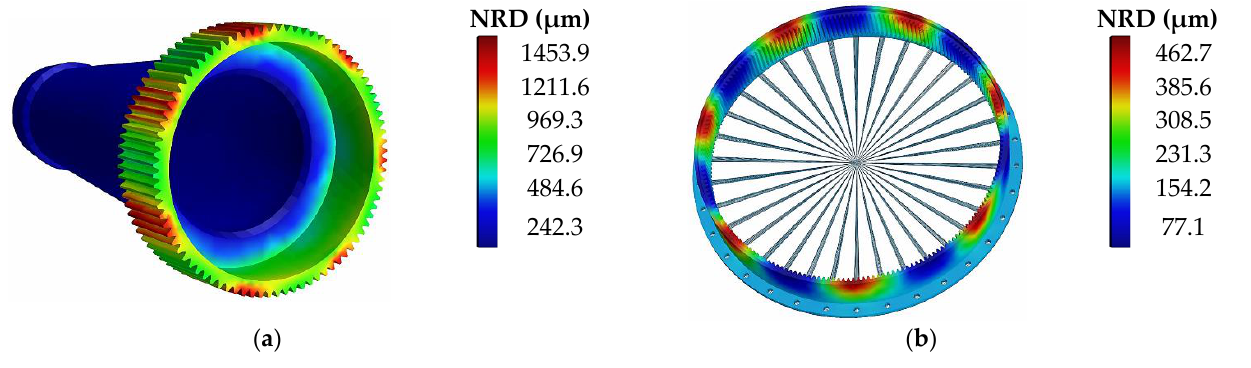
Figure 9. Elastic deformation result: ( a ) displacement nephogram of input shaft; ( b ) displacement nephogram of ring carrier.